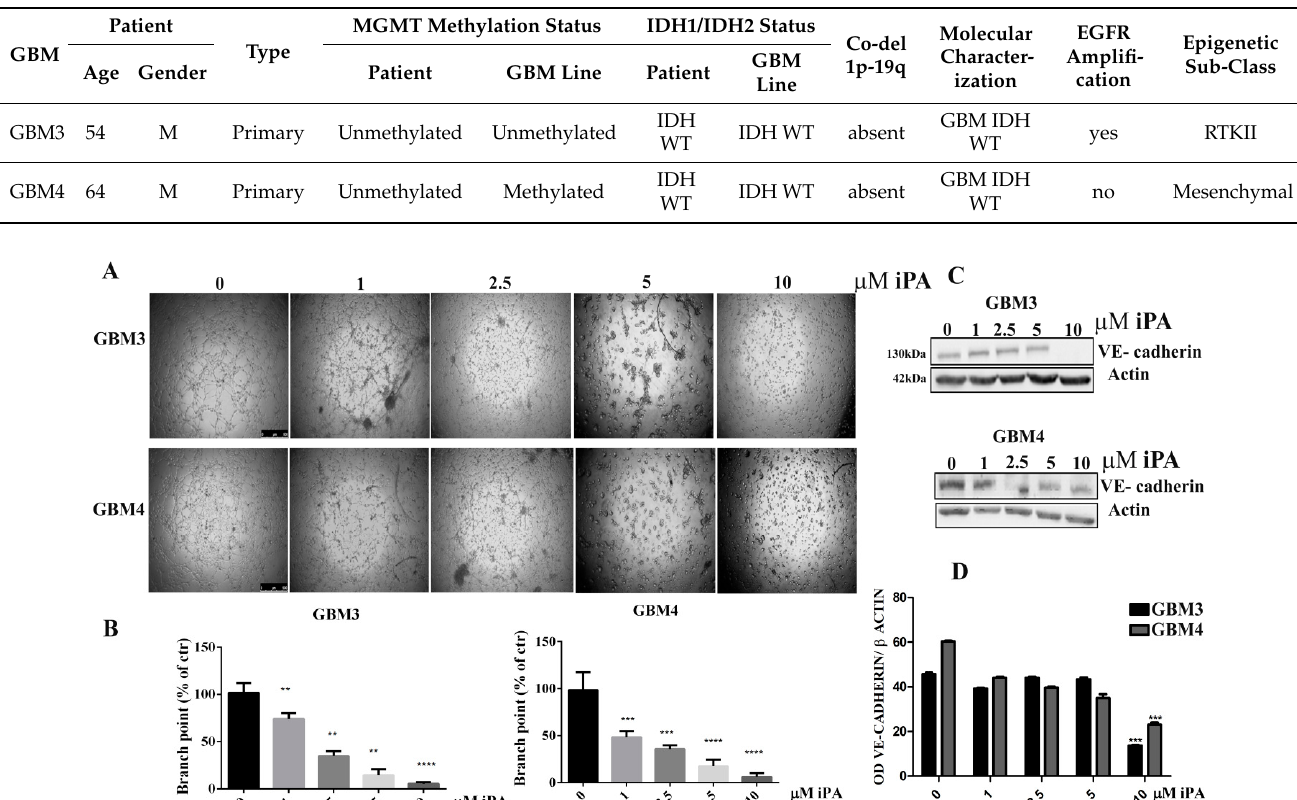
Figure 2. N6-isopentenyladenosine inhibits the tube formation in GBM primary cell lines. ( A ) Representative images of vascular tubes formed by primary cells in control group (DMSO) and in treated group at 18 h. iPA is used at several concentration. Network of tubes, in each well, were analyzed directly under an inverted microscope with 4× phase contrast and imaged. Scale bars: 250 µm. ( B ) Quantification of vascular branching. Branch point (sites of intersection of at least three tubes): the number in each well was counted. ( C ) Immunoblotting showing the effect of iPA on VE-cadherin in GBM primary cell lines. ( D ) Densitometric analysis of each Western Blot panel. Results were expressed as the mean ± SD of four independent experiments conducted in triplicate. (ANOVA, , ** p < 0.01, *** p < 0.001, **** p < 0.0001).